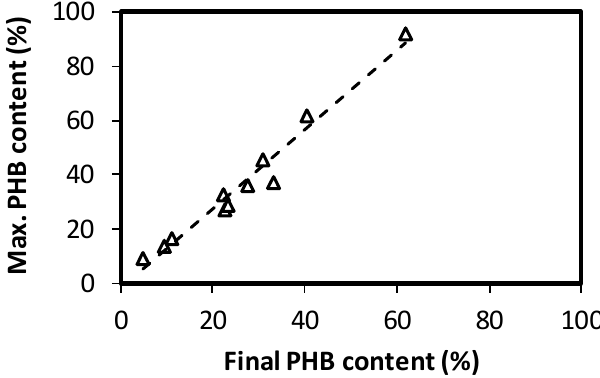
Figure 4. Relation between the maximum and final PHB contents for the operation of SBR reactors.